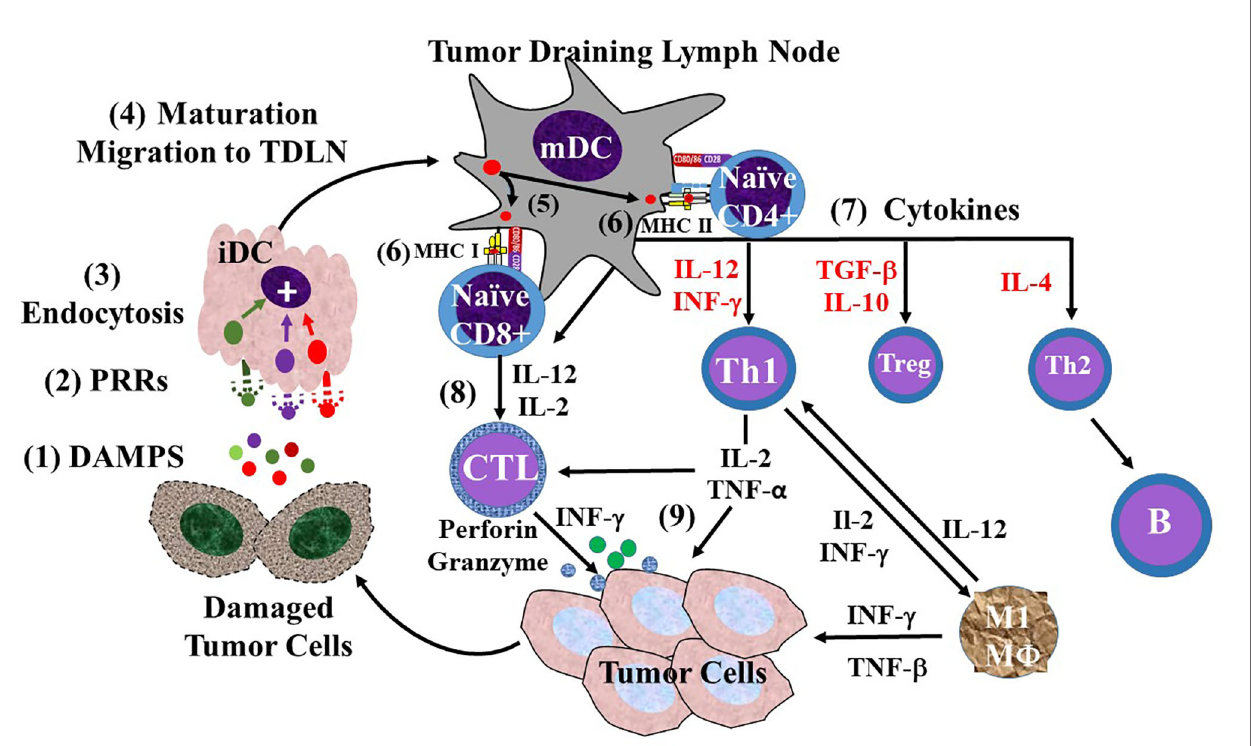
FIGURE 6 | Overview of the sequence of events involving dendritic cells in the tumor-associated immune response (TAIR). The TAIR begins with natural killer (NK) cell and macrophage (not shown) inducing damage of tumor cells that (1) releases damage-associated molecular patterns (DAMPs) into the tumor microenvironment (2). The DAMPs bind to various types of pattern recognition receptors (PRRs) on immature dendritic cells (iDCs) (3), where their endocytosis leads to activation of iDC maturation (4). iDC maturation leads to morphologic changes, decreased endocytic activity, migration lymphatics to a tumor draining lymph node (TDLN). Once in the TDLN, the now mature dendritic cell (mDC) provides the three signals needed for activation of naive T cells. mDCs are capable of cross-presenting antigens (5) to both major histocompatibility complex (MHC I and MHC II) molecules of the surface. Signal 1 (6) is generated by the MHC molecule presentation of the antigen to the T-cell receptor (TCR) on naive CD 4 or CD8 T cells. Signal 2 is generated by the binding of co-stimulatory molecules CD80/86 on the mDC to CD28 on the naive T cells (7). Signal 3 is provided o the release of pro-in fl ammatory cytokines (e.g., IL-2, IL-12, IFN- g ) that activate naive CD4+ T-helper (Th) cells to differentiate into different populations based on the cytokine milieu (red text). These include IL-2 and TGF- b stimulated CD4 regulatory T cells (Treg), and IL-4 stimulated Th2 cells. However, IL-12 induced differentiation of naive CD4 cells into Th1 cells in the major antitumor effector T cells (8). Activation of naive CD8 by IL-12 and IL-2 leads to their differentiation into CD8+ cytotoxic T lymphocytes (CTLs). The Th1s and CTLs migrate back to the tumor cells via blood vessels (9). The tumor-associated immune response (TAIR) involves the Th1 cells activating M1 macrophages (M F ), CTL release of perforin and granzyme, and release of IL-2 and TNF- a that work together to damage tumor beyond